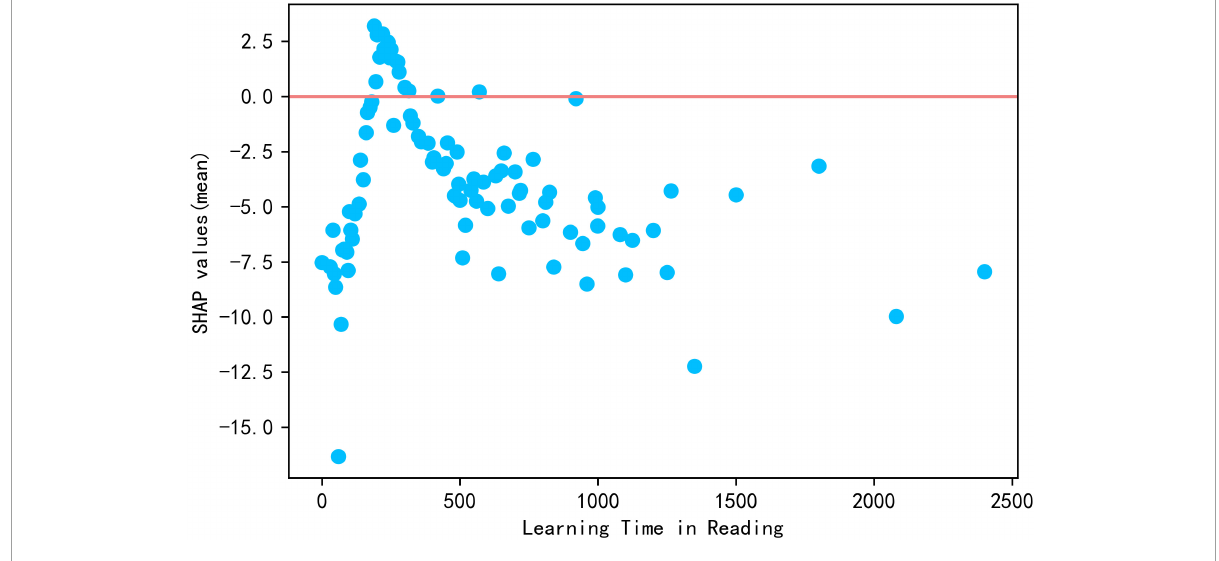
FIGURE7 The scatter plot of reading learning time and Shap values.